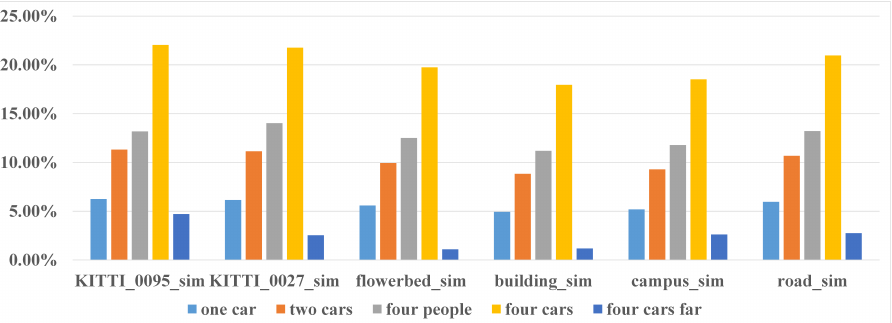
Figure 10. The moving objects proportion of the five scenarios in the six datasets of semi-physical